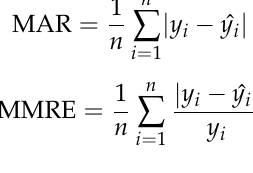
Figure 12. Total number of use cases and suitability for estimation.